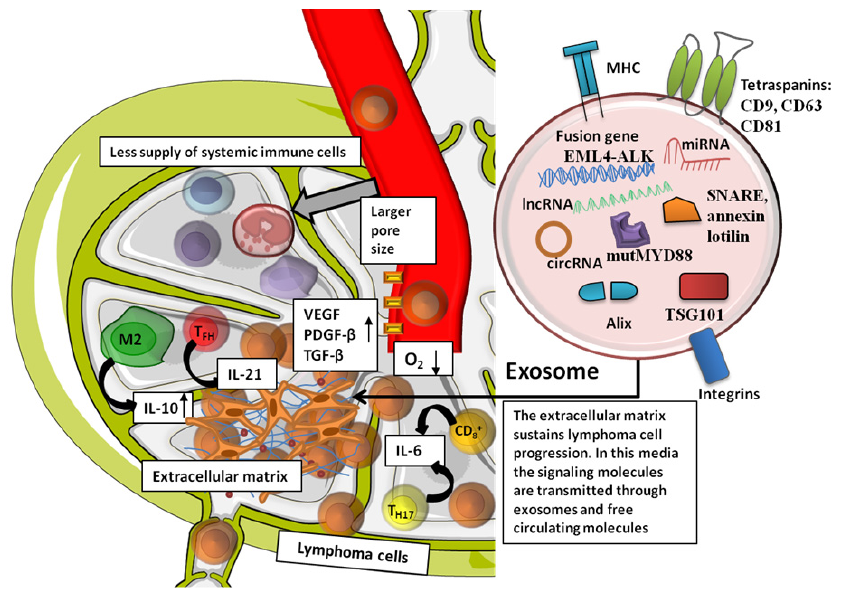
Figure 1. The role of extracellular matrix in lymphoma development and progression, an exemplification of the sequence of events happening inside the malignant lymphoid tissue. The vascular network is disorganized, and it has larger pores compared to normal blood vessels, due to overexposure to vascular endothelial growth factor (VEGF), platelet-derived growth factor (PDGF- β ), and transforming growth factor (TGF- β ). Due to these characteristics, the local microenvironment is hypoxic and there is a general lack of systemic immune cell provision, while the local immune cells secrete cytokines meant to facilitate lymphoma cell proliferation and invasion. The lymphoma cells (represented in the current figure in round brown) are at a higher number than all the other non-malignant immune cells in the lymphoma microenvironment. They arrive in the lymphoid organ through extravasation from general blood circulation, helped by locally modulated immunity, and the lymphoma cells proliferate and become more aggressive, until they start to leave the lymph node and enter into the lymphatic circulation. Inside the malignant lymphoid tissue, the macrophages are polarized to M2 phenotype and secrete interleukin-10 (IL-10), meaning that they have anti-inflammatory and malignancy-promoting properties. The T follicular helper (TFH) cells secrete IL-21, and the T helper (Th) Th17 and CD8 + T cells secrete IL-6. Th17 cells have a dual role by inhibiting regulatory T cells (Tregs), but also stimulating malignant proliferation of B cells. CD8 + cells (cytotoxic T cells, CTL) inhibit lymphoma progression, but they are in a small number in the lymphoma microenvironment. However, the main mechanism through which the lymphoma progression is sustained by the extracellular environment is due to the secretion of exosomes by the immune cells (T or B lymphocytes) and the lymphoma cells (of B or T origin). In the top right part of the figure, in the circle, there is a representation of an exosome.